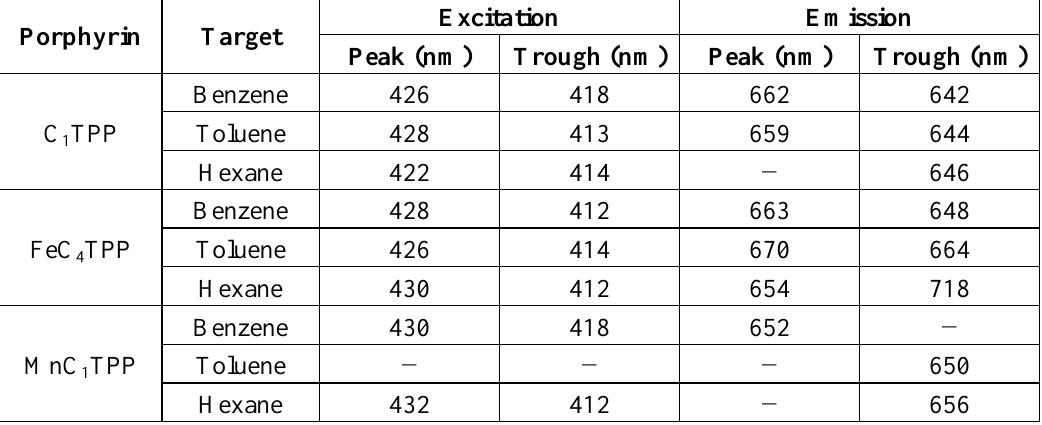
Table 3. Interaction of porphyrin embedded materials with benzene, toluene, and hexane. Peak and trough positions are taken from difference